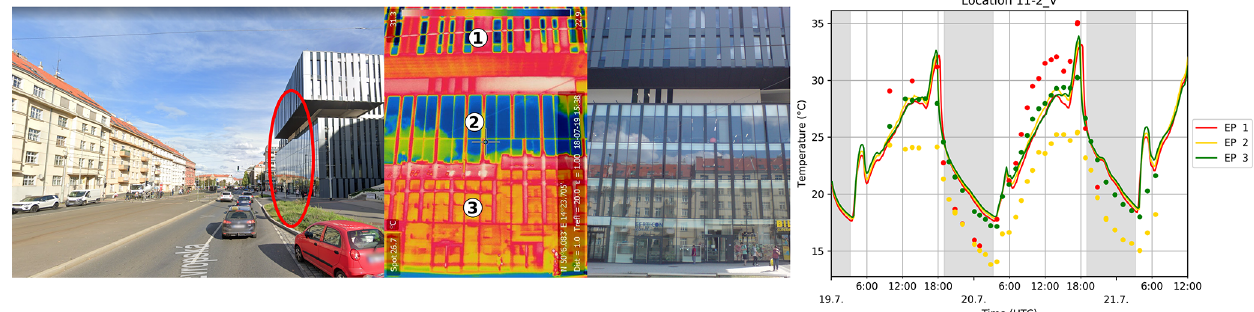
Figure 16. Observation location 11-2_V: the left panel shows the observation location; the centre panels show IR and RGB photos of the building and the placement of the evaluation points; the right panel displays a graph of observed (dots) and modelled (lines) surface temperature for particular evaluation points (EP) for the summer e2 episode. The grey areas denote night-time. The image in the left panel was sourced from © Google Maps